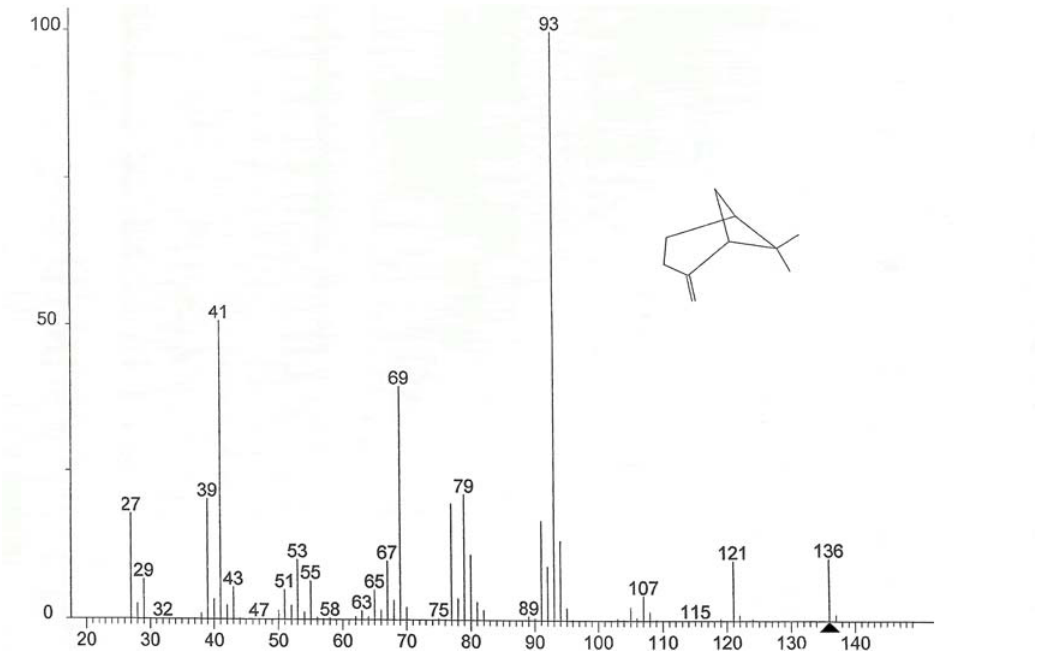
Figure 4. Mass spectra of 